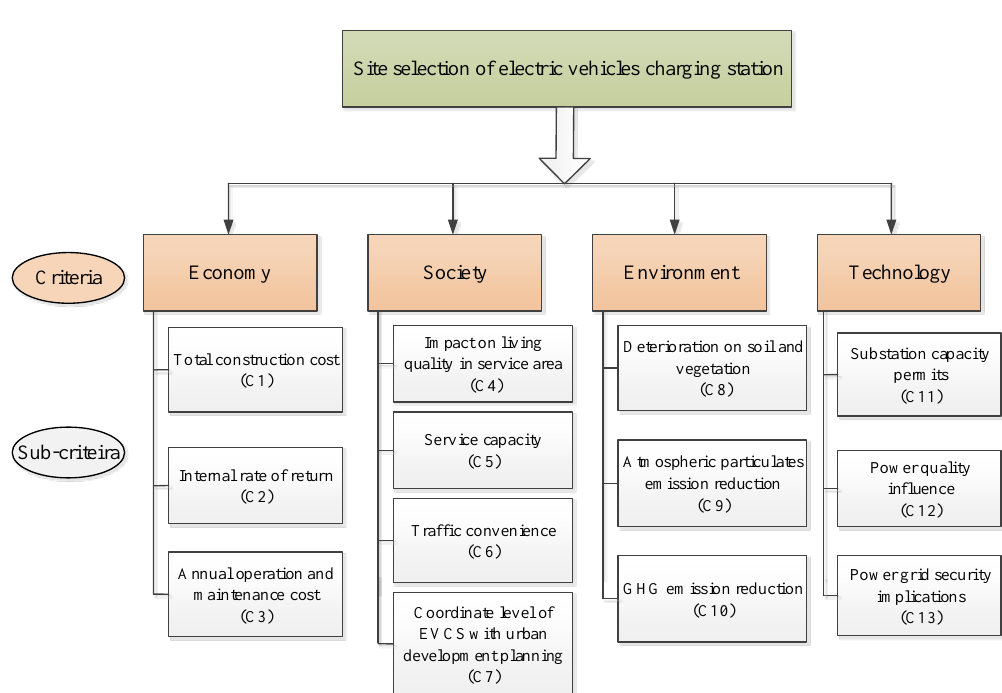
Figure 2. Evaluation index system for optimal siting of charging stations for electric vehicles.